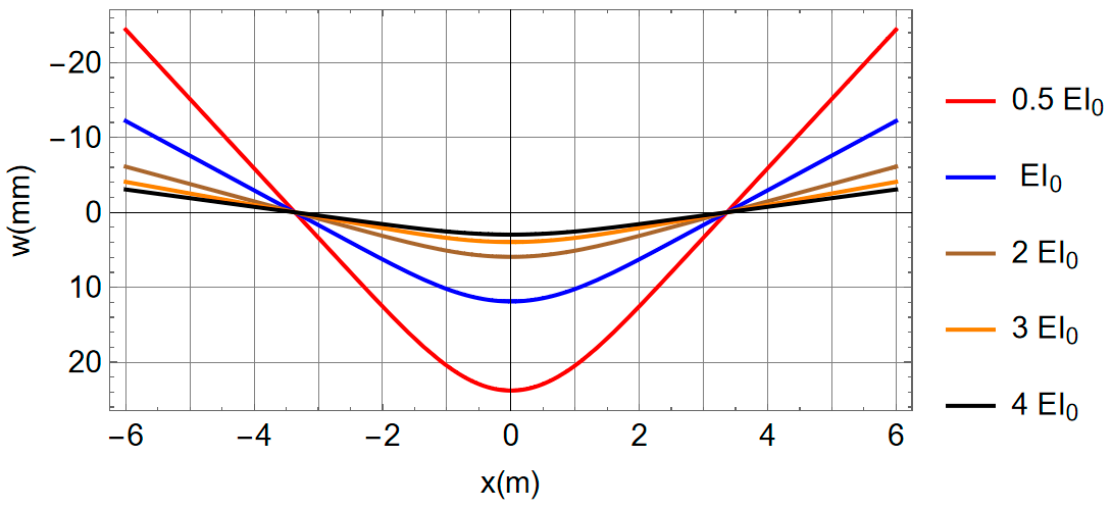
Figure 17. The beam deflection at different stiffness levels and maintaining same 𝐸𝐼/𝑘 ratio (Case 4).